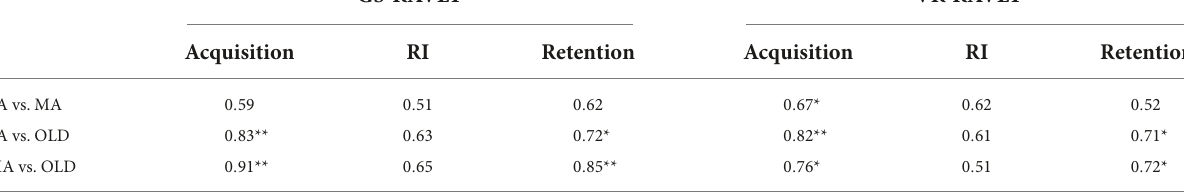
TABLE 4 AUC values from ROC